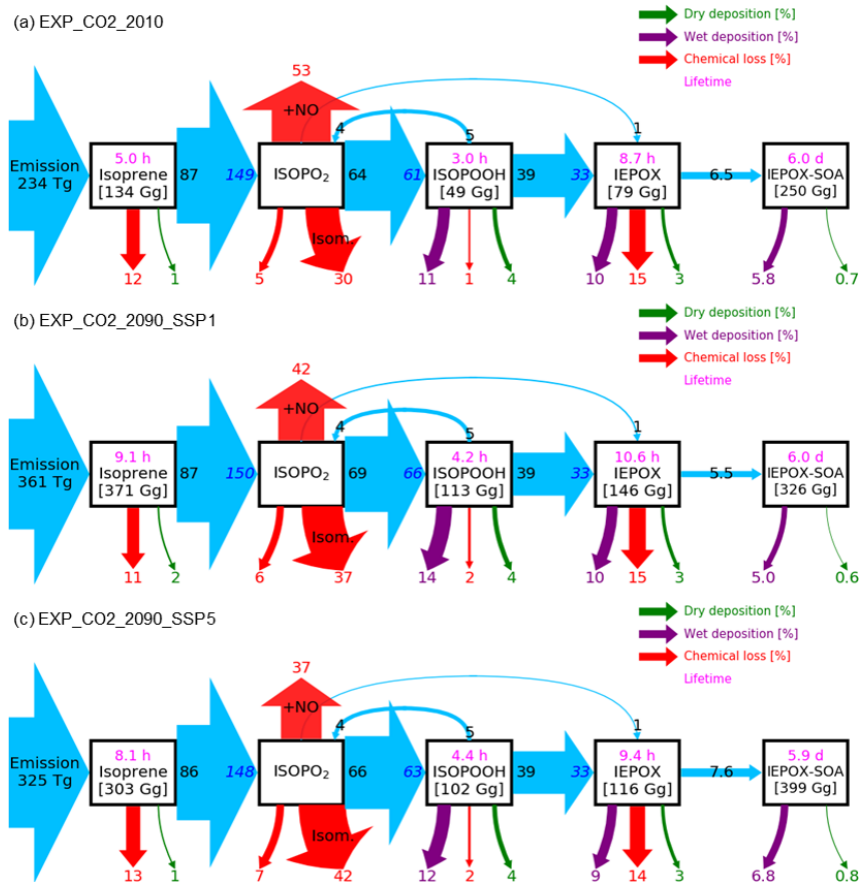
Figure 10. Same as Fig. 6 but for EXP_CO2 simulations (CO 2 inhibition effect is taken into